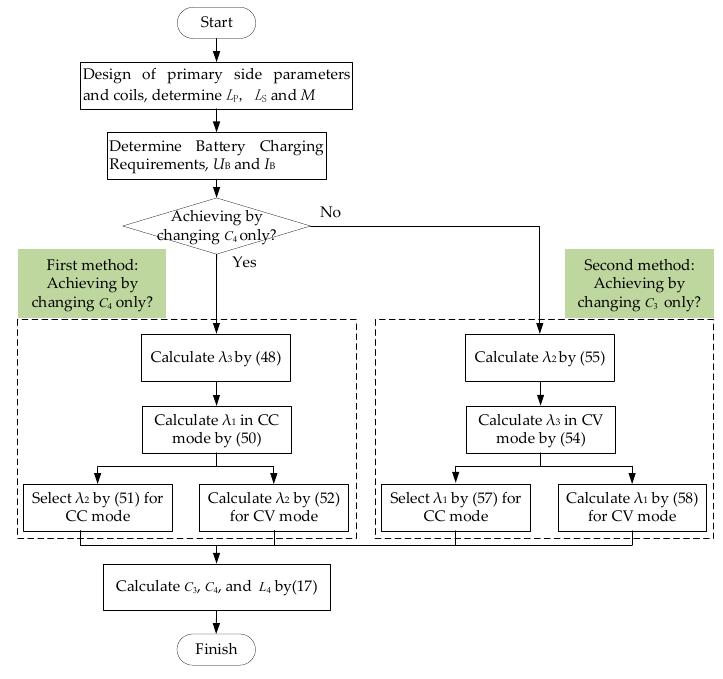
Figure 10. Flowchart of parameters design.